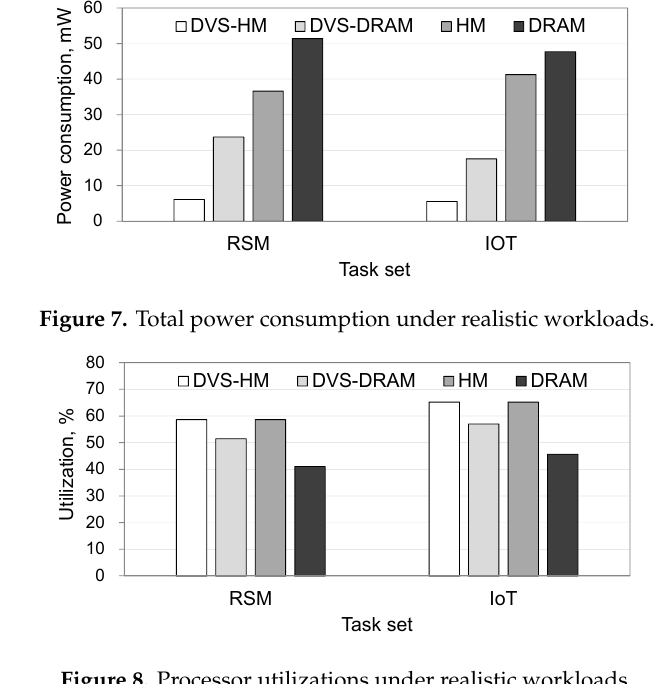
Figure 8. Processor utilizations under realistic workloads.